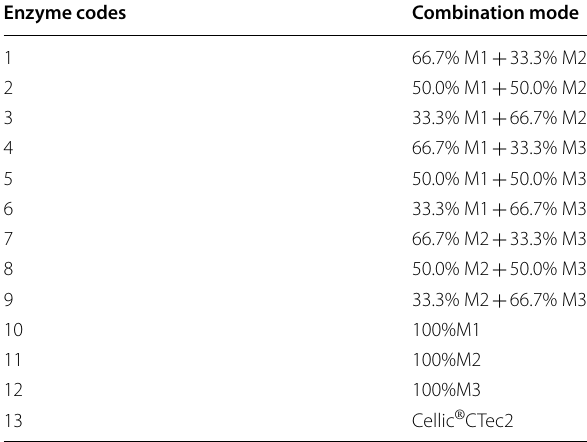
Table 1 The blends of enzyme cultured in different carbon sources and commercial